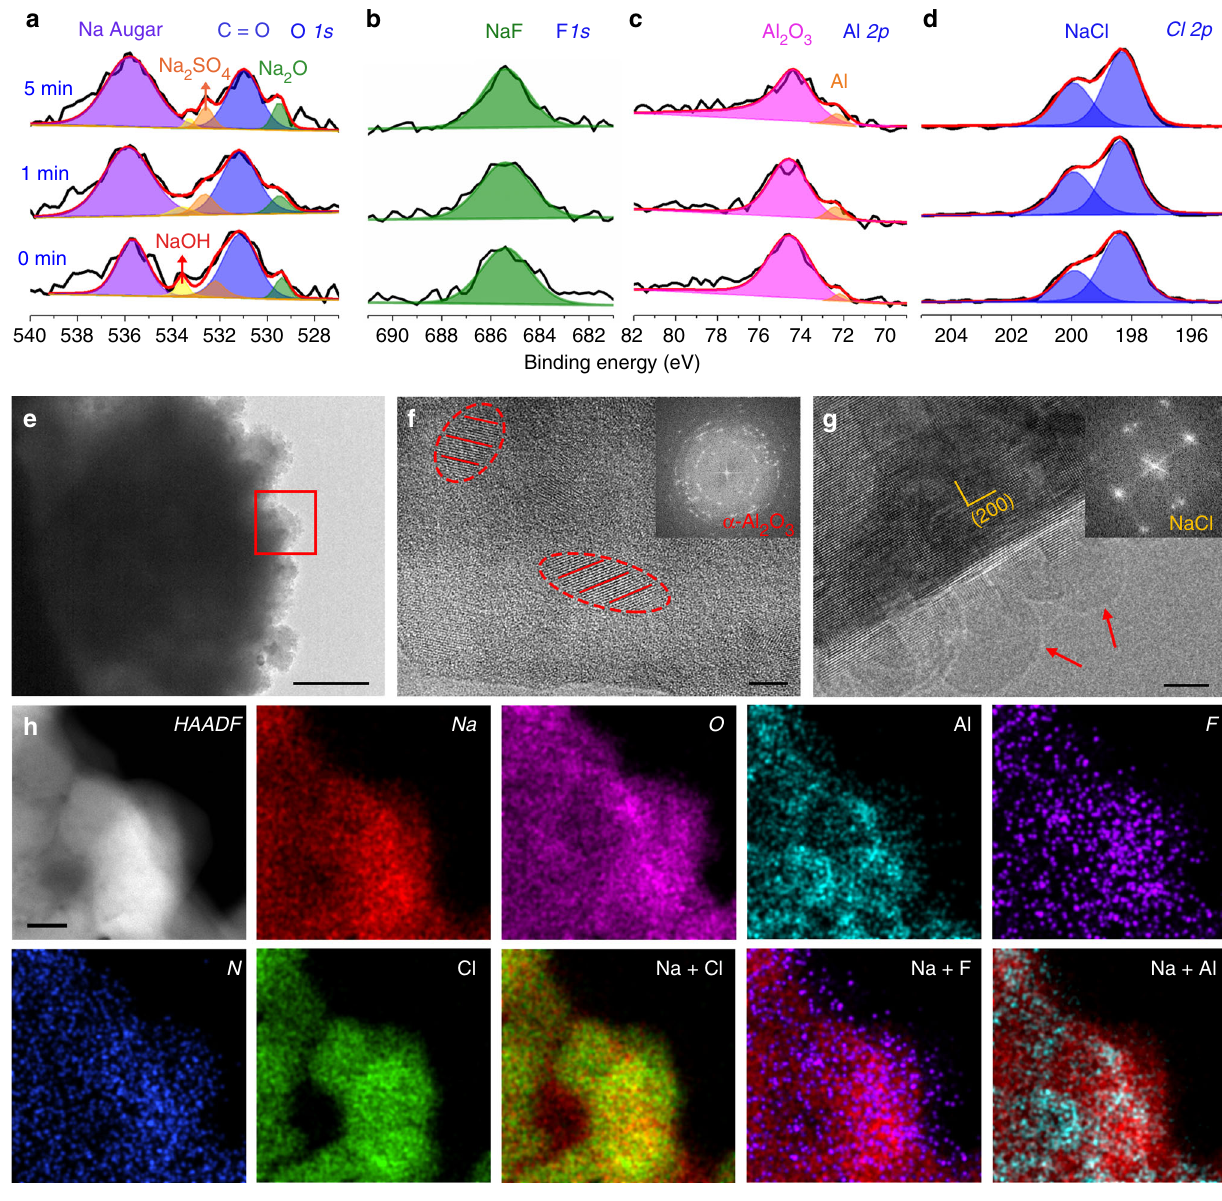
Fig. 5 Morphology and solid-electrolyte interphase (SEI) probing of the plated Na in buffered Na – Cl – IL electrolyte. a – d High-resolution XPS spectra for Na Auger and O1s ( a ), F 1 s ( b ), Al 2 p ( c ) and Cl 2 p ( d ) of the Na negative electrode from a Na/NVP@rGO cell with NVP@rGO mass loading of 5.0 mg cm − 2 at different depths, respectively. The cell was cycled at 100 mA g − 1 (~0.5 mA cm − 2 ) for 20 cycles and stopped at fully charged state prior to characterization. e Cryo-TEM image of Na-plated Cu grid at a current density of 0.1 mA cm − 2 . Scale bar, 500 nm. f , g High-resolution Cryo-TEM images and diffraction patterns (inset) of SEI concerning Al 2 O 3 and NaCl. Scale bars in ( f , g ), 5 nm. h High-angle annular dark- fi eld (HAADF) and the corresponding element mapping images for SEI composition probing using STEM. Scale bar, 100